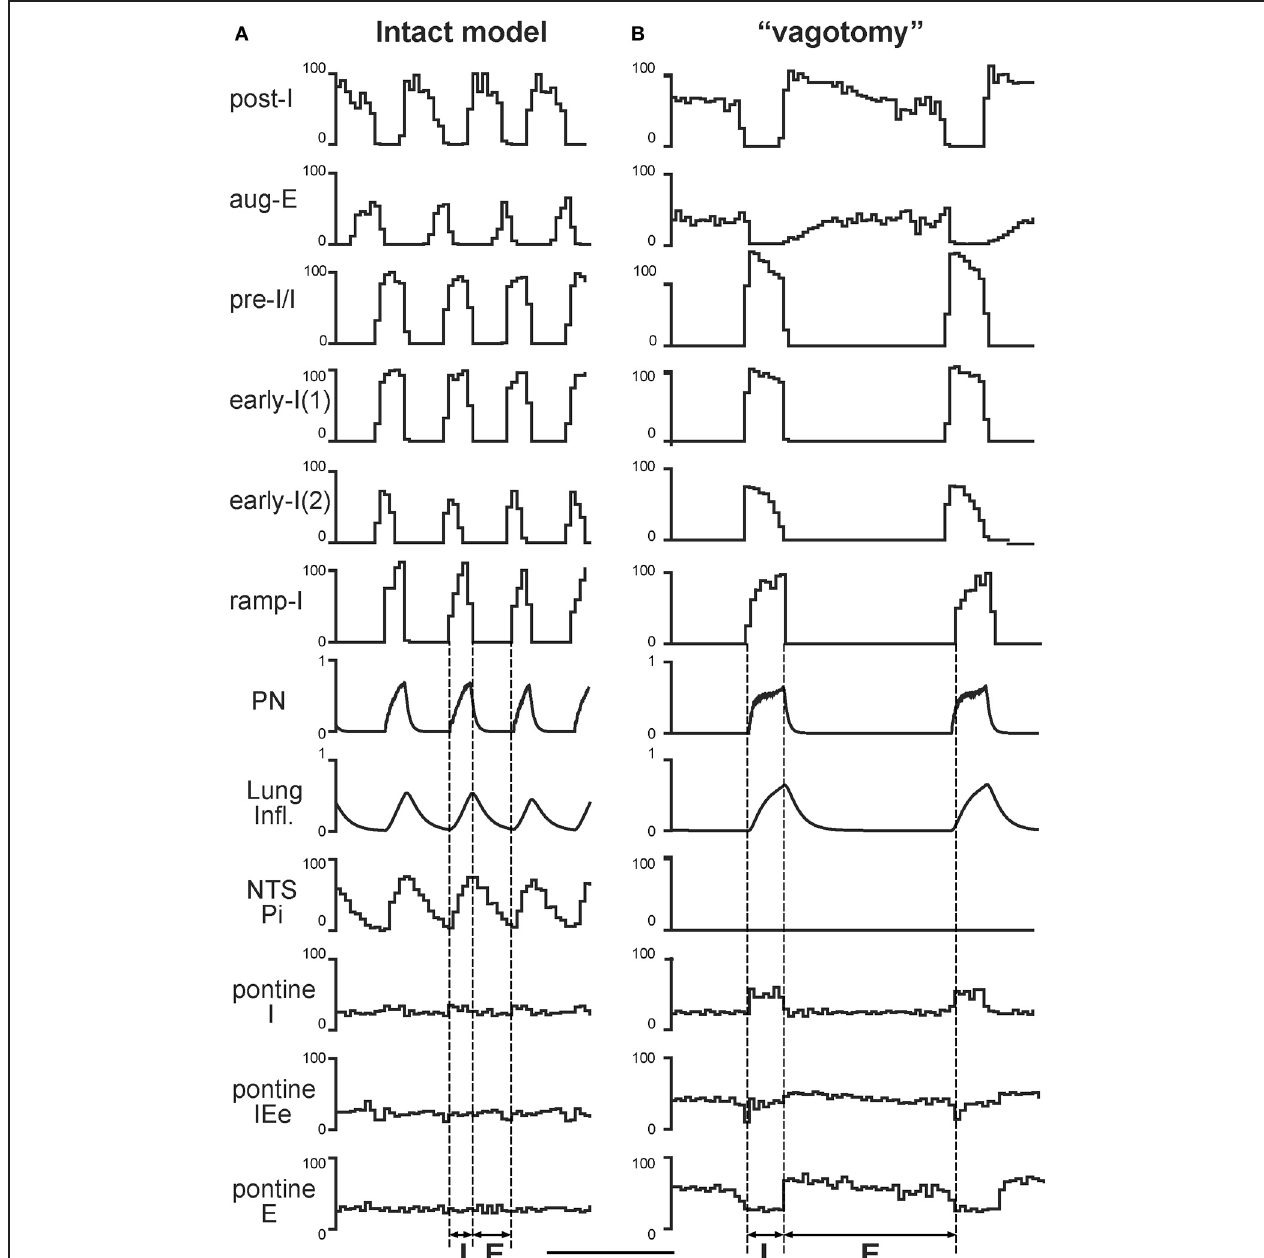
FIGURE 3 | Simulated vagotomy (removal of the pulmonary feedback). Activity of major VRC (post-I, aug-E, early-I(1), pre-I/I, early-I(1), early-I(2), and ramp-I), NTS (Pi) and pontine (I, IEe, and E) neural populations, lung